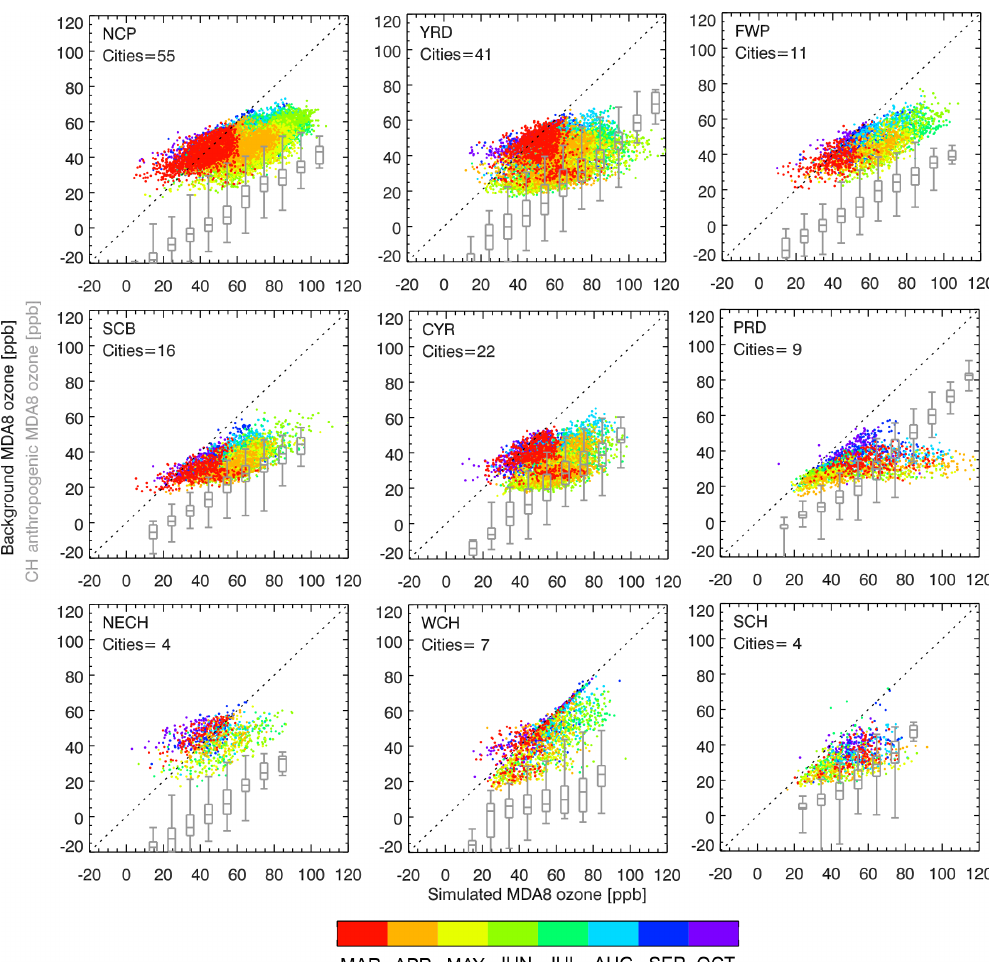
Figure 6. Simulated daily MDA8 ozone ( x axis) and corresponding background contributions ( y axis) in the nine city clusters for March– October 2017 with different months denoted in different colors. Also shown are box-and-whisker plots (minimum, 25th, 50th, and 75th percentiles, and maximum) of domestic anthropogenic ozone enhancements ( y axis) over 10ppbv bins of simulated ozone concentrations. The 1 : 1 line and number of cities in each cluster are